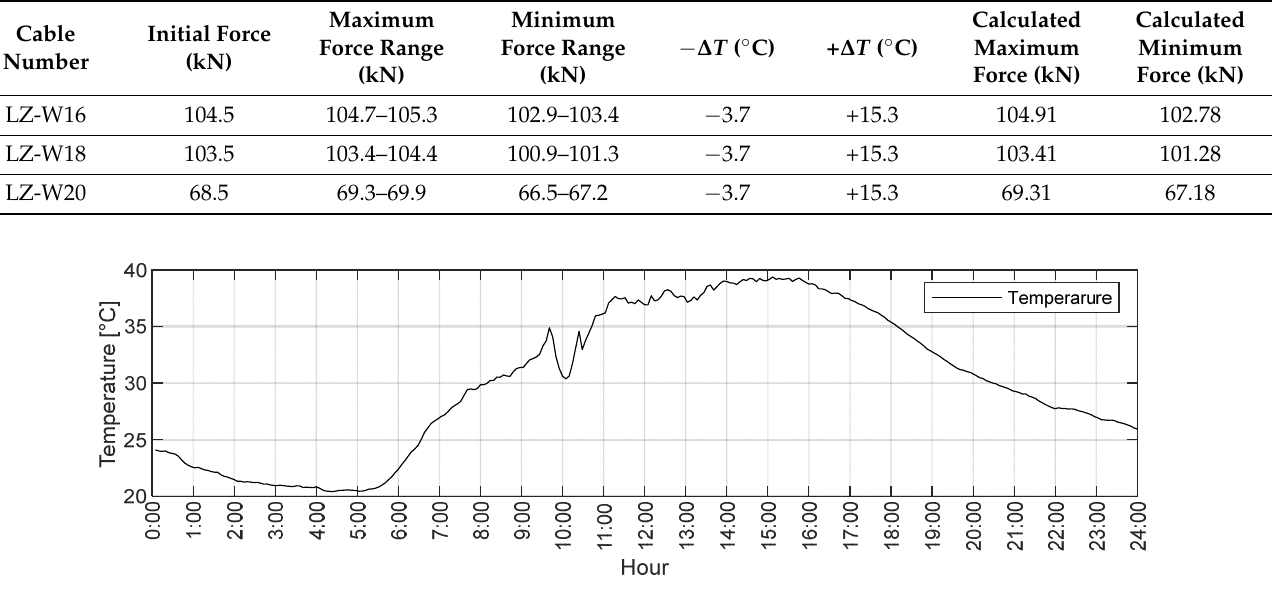
Figure 9. Daily strands temperature change (1 August 2017).